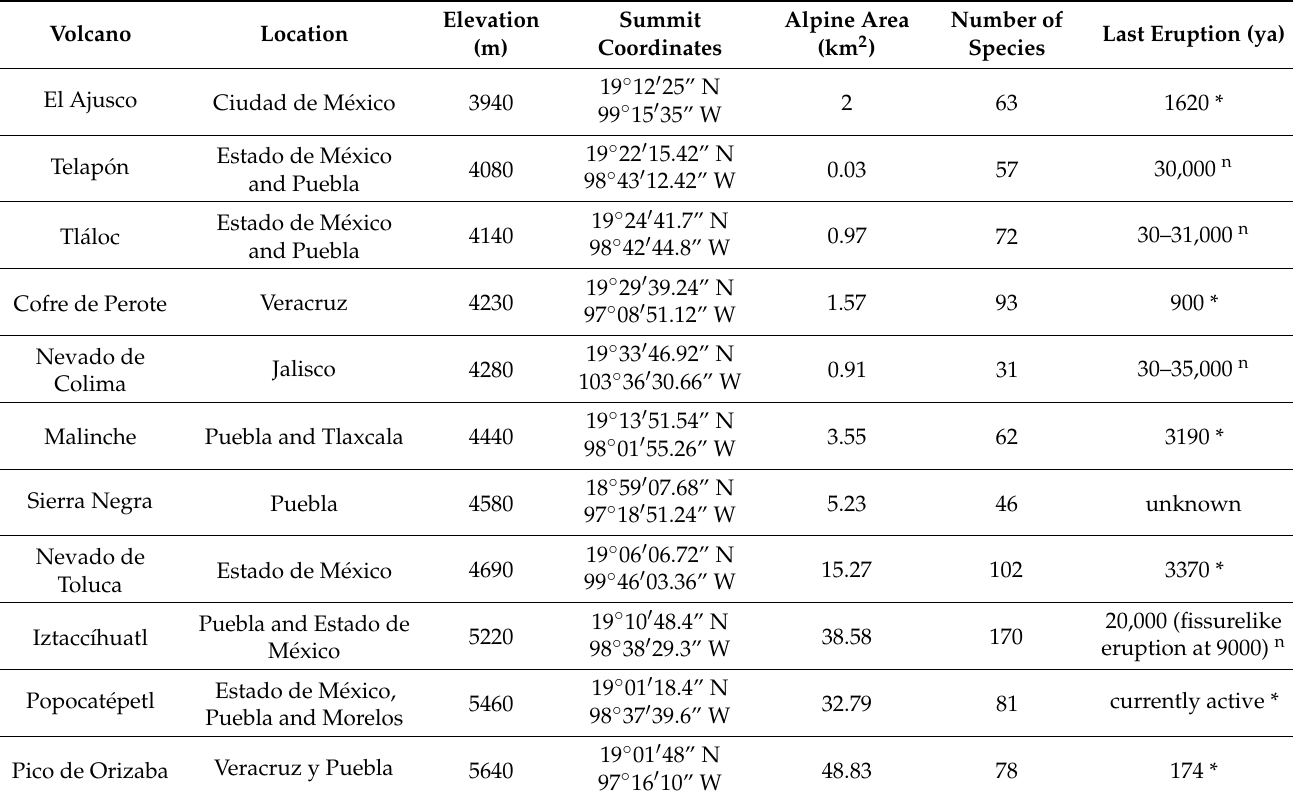
Table 1. General information about location, diversity, and volcanic activity of the study sites. Source: * Global Volcanism Program; n Neyra,